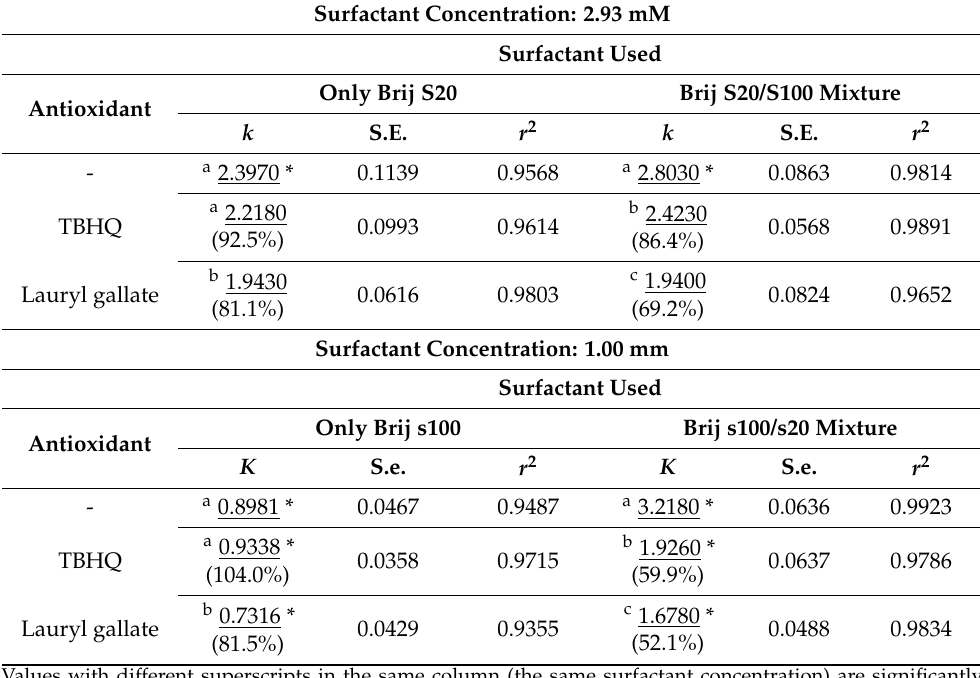
Table 2. Production rate constant ( k ( µ mol/kg emulsion/day)) of TBARSs of emulsions stabilized with Brij surfactant mixtures at a surfactant concentration of 2.93 and 1.00 mM at pH